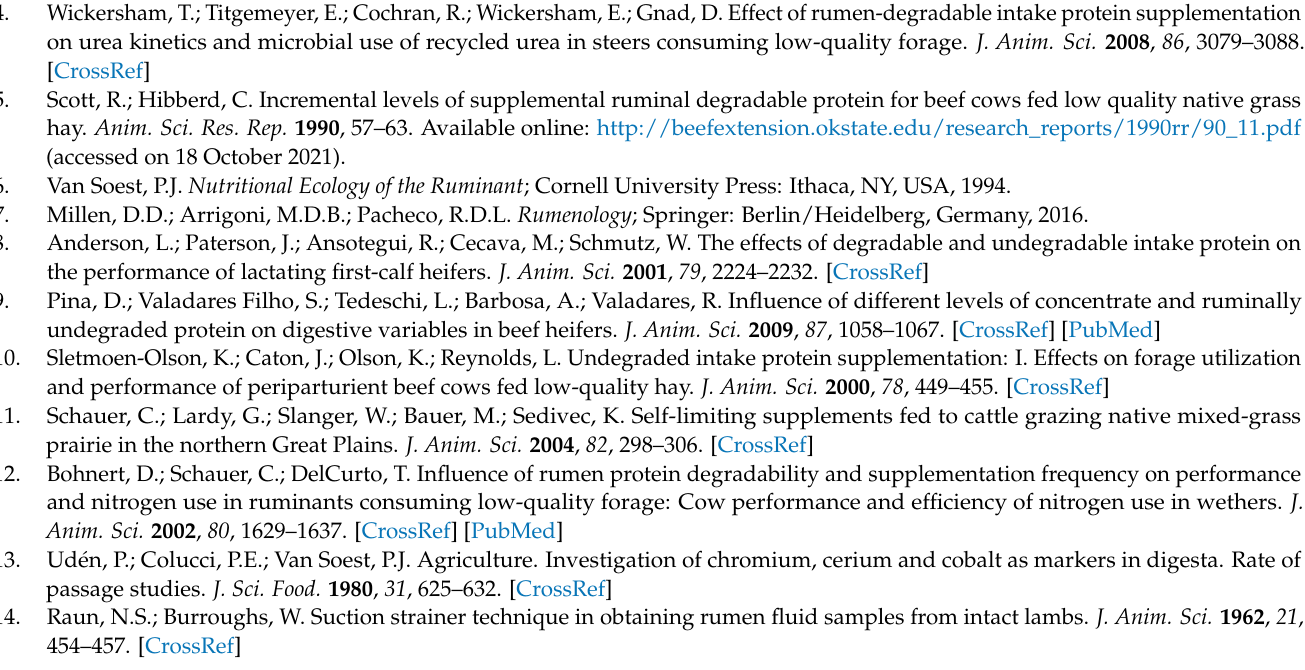
Table S2: Dry matter intake, digestibility, rumen fill, fluid flow rate, and undigestible neutral detergent fiber data based on delivery method and protein type, and Table S3: Ammonia and volatile fatty acid data for cattle based on delivery method and protein